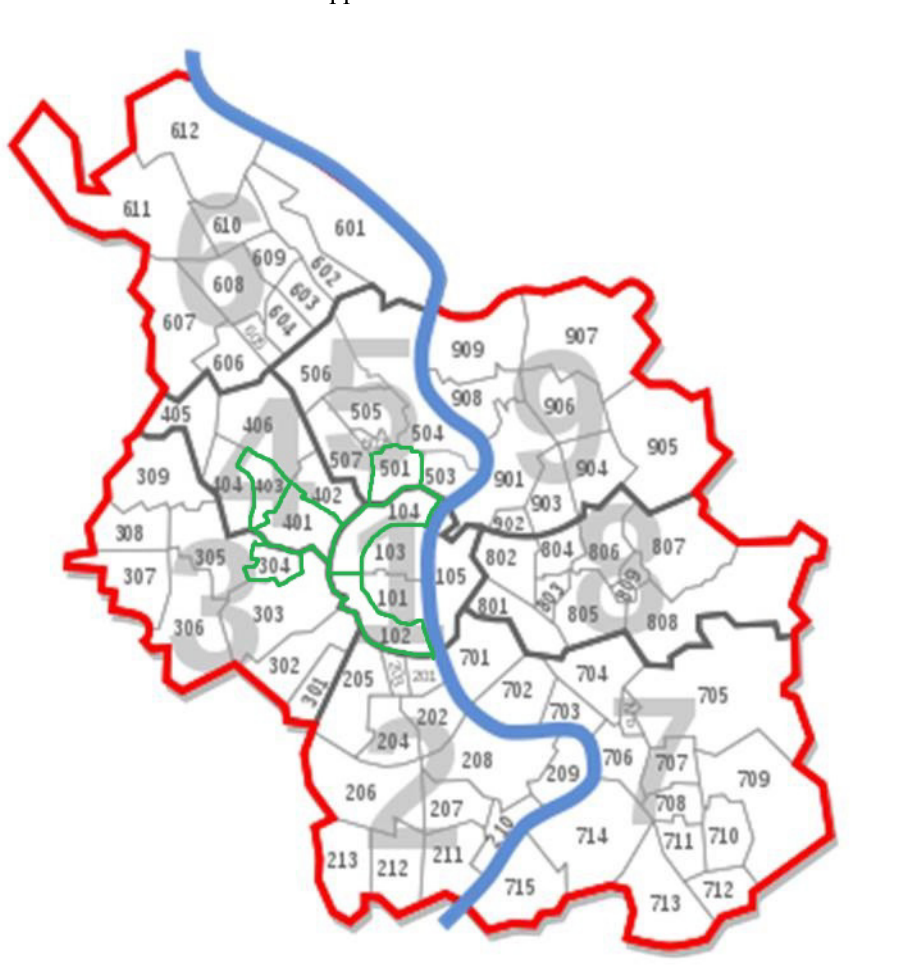
Figure 1. City districts of Cologne [11]. The selected parts of the city (framed in green)